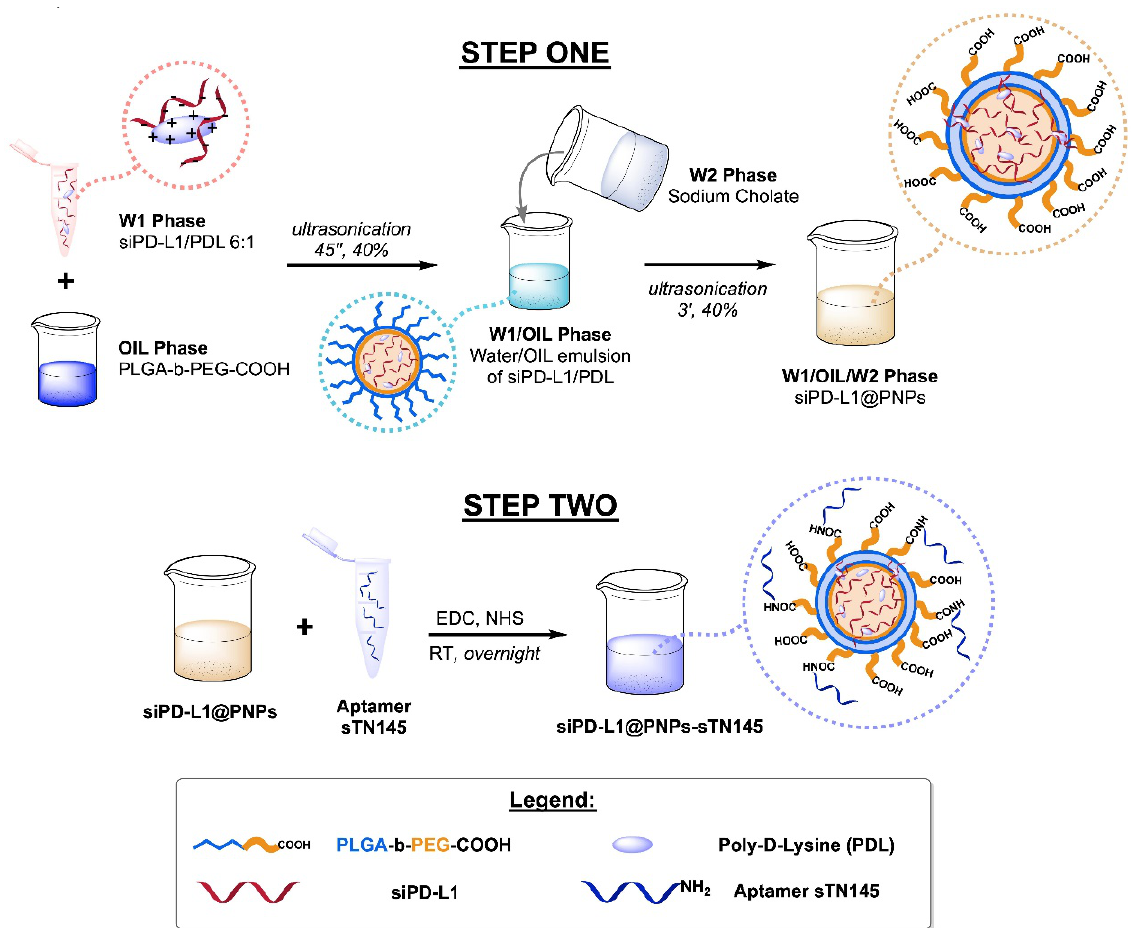
Figure 1. Schematic representation of the water-in-oil-in-water workflow for obtaining the final PNPs. Encapsulated siRNA and covalently labeled aptamer molecules (and scrambled sequence) were used for loading/decorating multifunctional nanovectors.